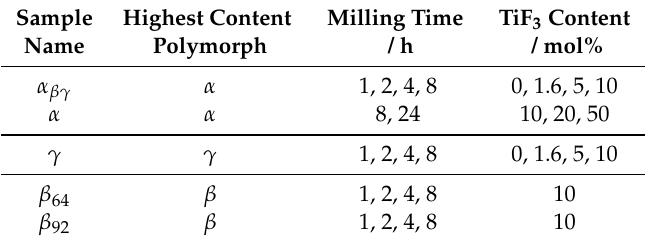
Table 2. Sample preparation